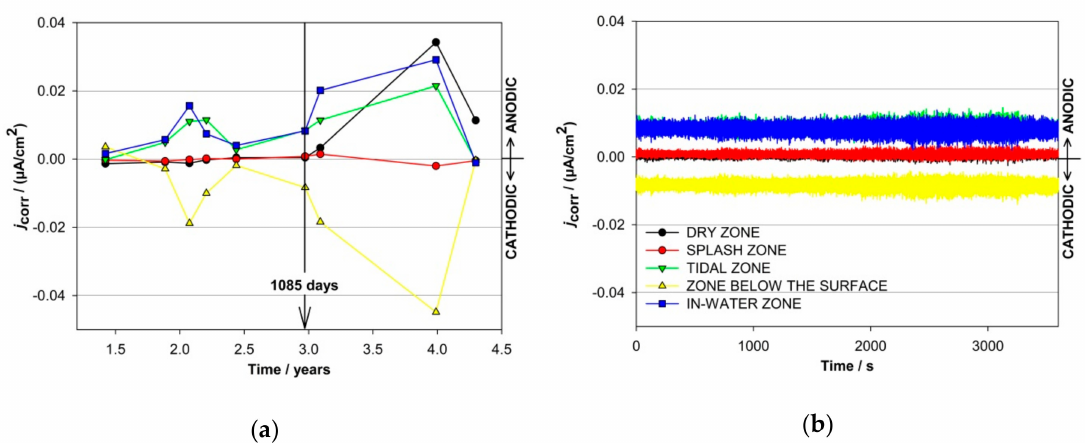
Figure 5. ( a ) Average values of the partial currents and ( b ) individual measurements of the partial currents after 1085 days of exposure on stainless steel-coupled multi-electrodes exposed to di ff erent zones of exposure in column